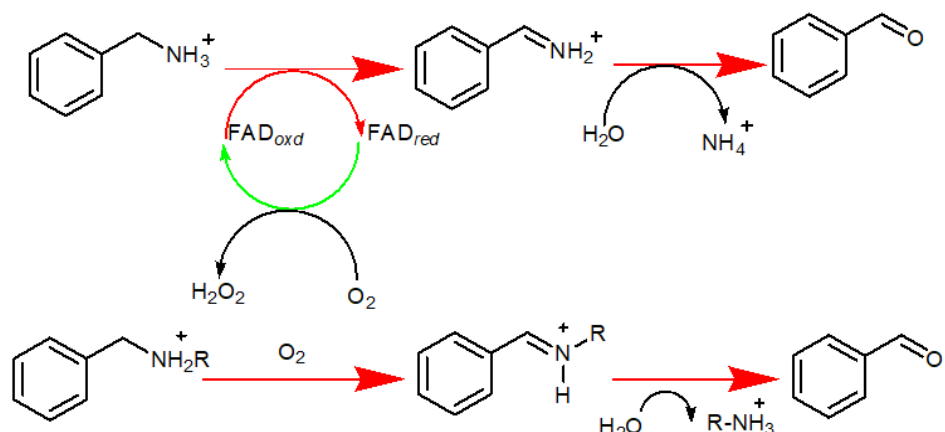
Figure 1. Oxidation of primary and secondary amines into their respective imine form, followed by nonenzymatic hydrolysis to their corresponding aldehydes or ketones.